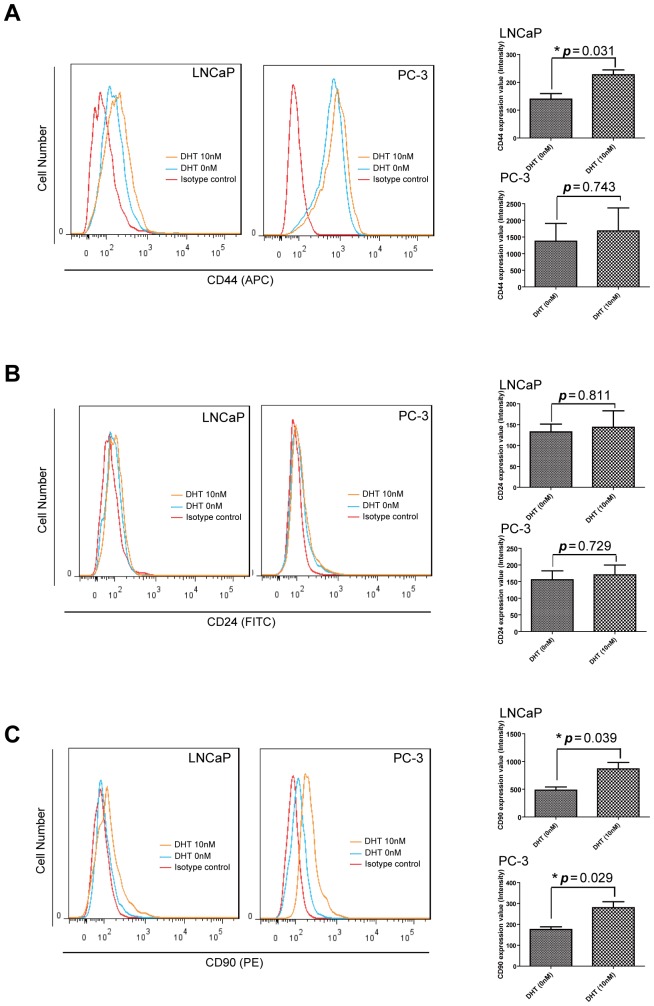
Stem-like phenotype analyses by flow cytometry.(A–C) CD44, CD24 and CD90 expressions were analyzed by flow cytometry in LNCaP and PC-3 cells cultivated with/without DHT in 10 nM for 48 hours. CD44 was induced by DHT treatment in both cell lines (A). No statistically significant difference of CD24 expression level was shown in both cell lines (B). CD90 expression was significantly increased by DHT stimulation in both cell lines (C). (* means P<0.05).